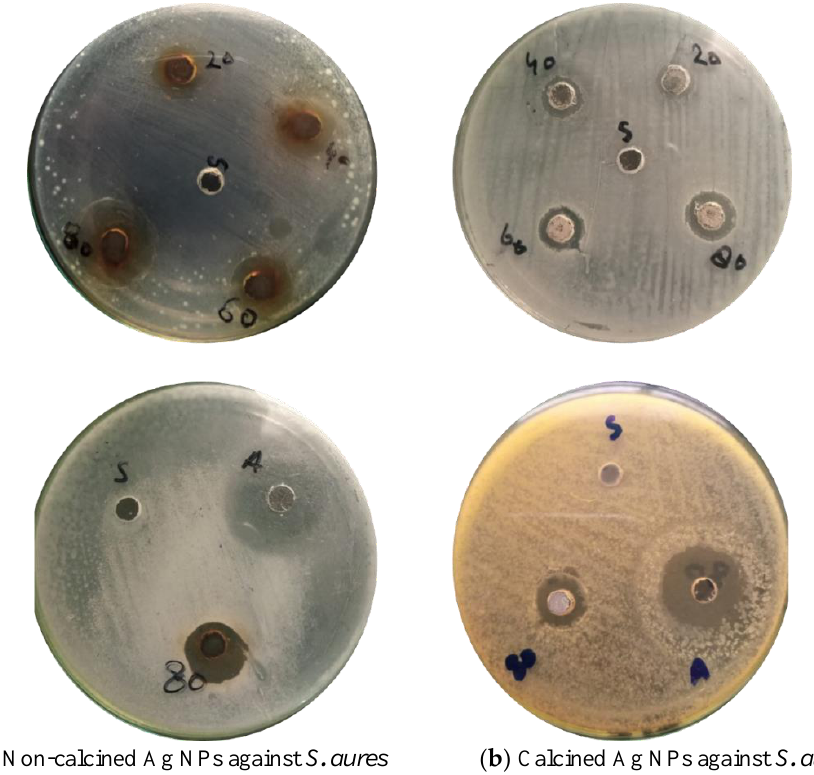
Figure 7. Antibacterial activity of biosynthesized ( a ) Non-calcined Ag NPs against S. aures, ( b ) Calcined Ag NPs against S. aures